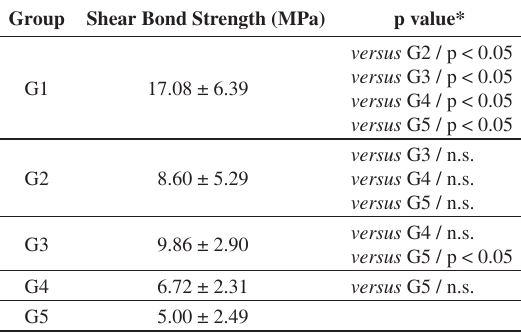
Table 1. Means and standard deviations of measured bond strengths in the 5 groups. Group Shear Bond Strength (MPa)